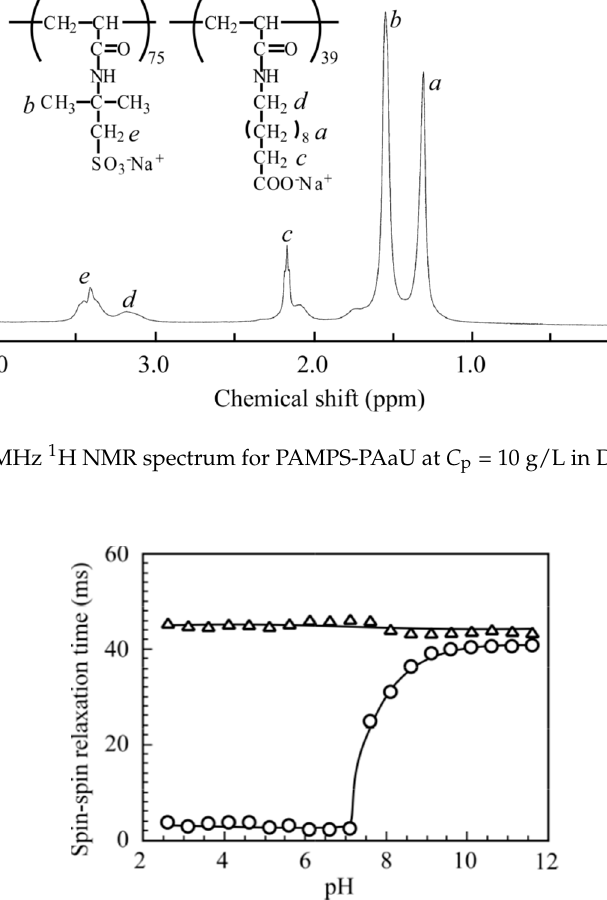
Figure 2. Spin-spin relaxation time ( T 2 ) for the pendant methylene protons in the PAaU block at 3.2 ppm ( ○ ) and the pendant methylene protons in the PAMPS block at 3.4 ppm ( ) in PAMPS–PAaU as a function of pH in D 2 O containing 0.1 M NaCl at C p = 10 g/L.